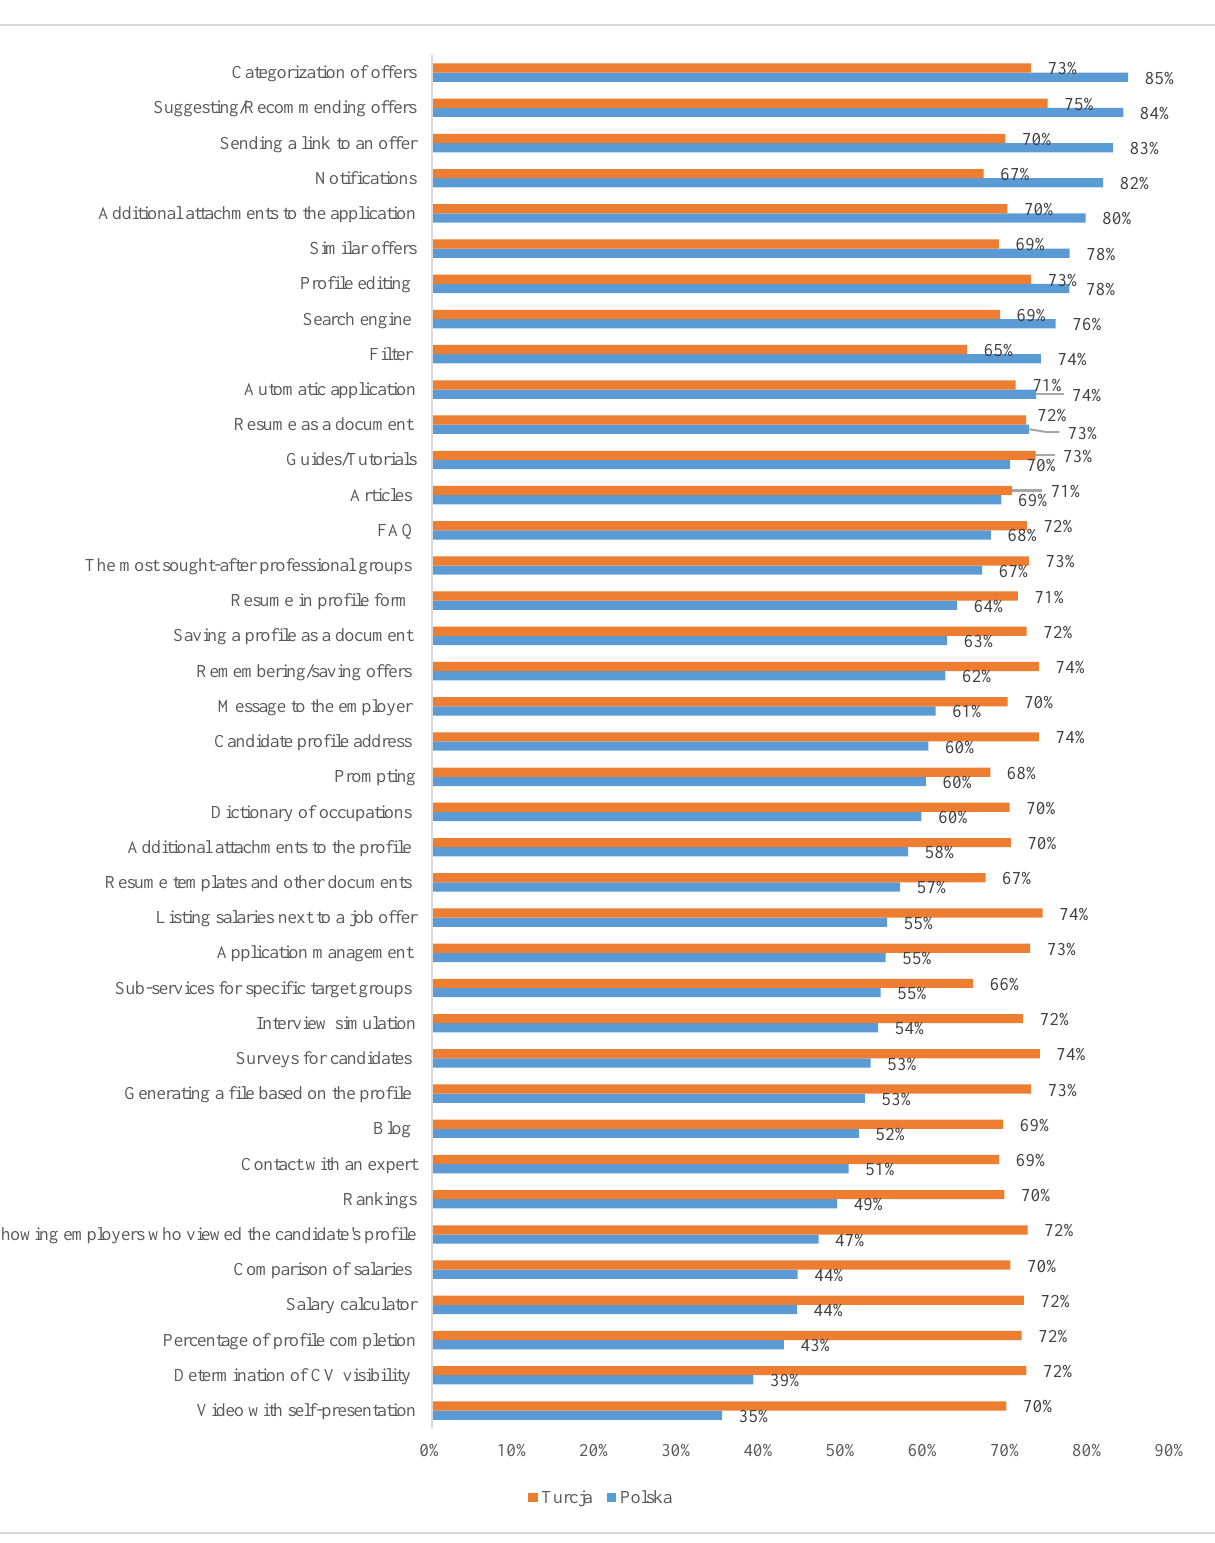
Figure 5. Attributes meeting the requirements of HR portal users in Poland and Türkiye in 2022; Source: own study.